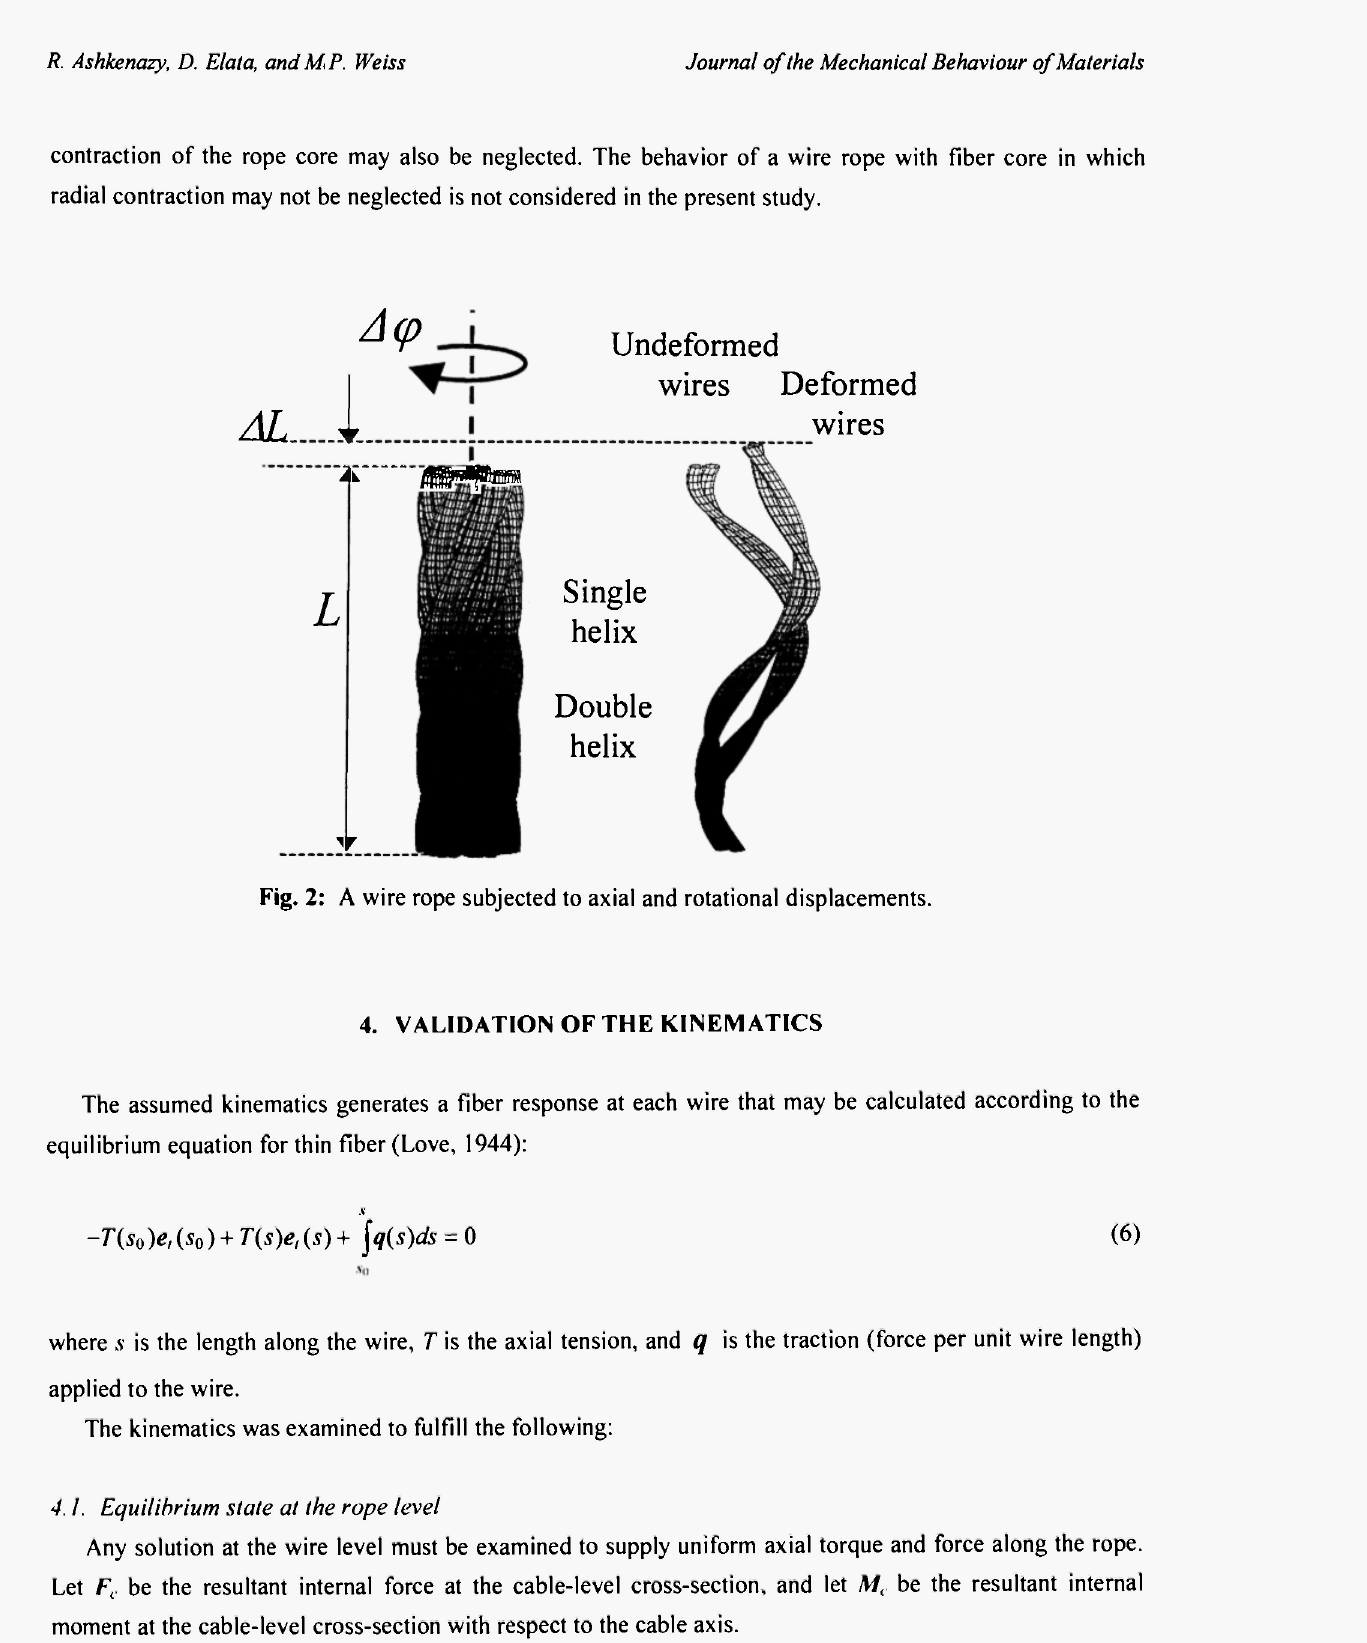
Fig. 2: A wire rope subjected to axial and rotational